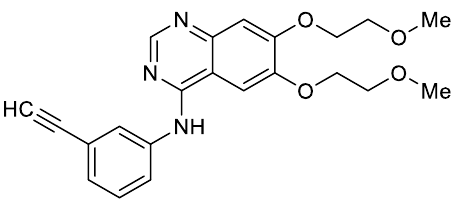
Figure 9. Structure of erlotinib.